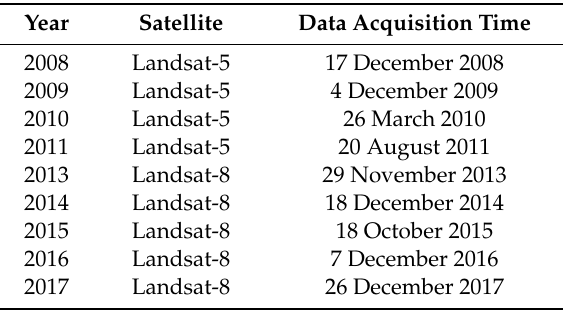
Table 1. Cloud-free Landsat data